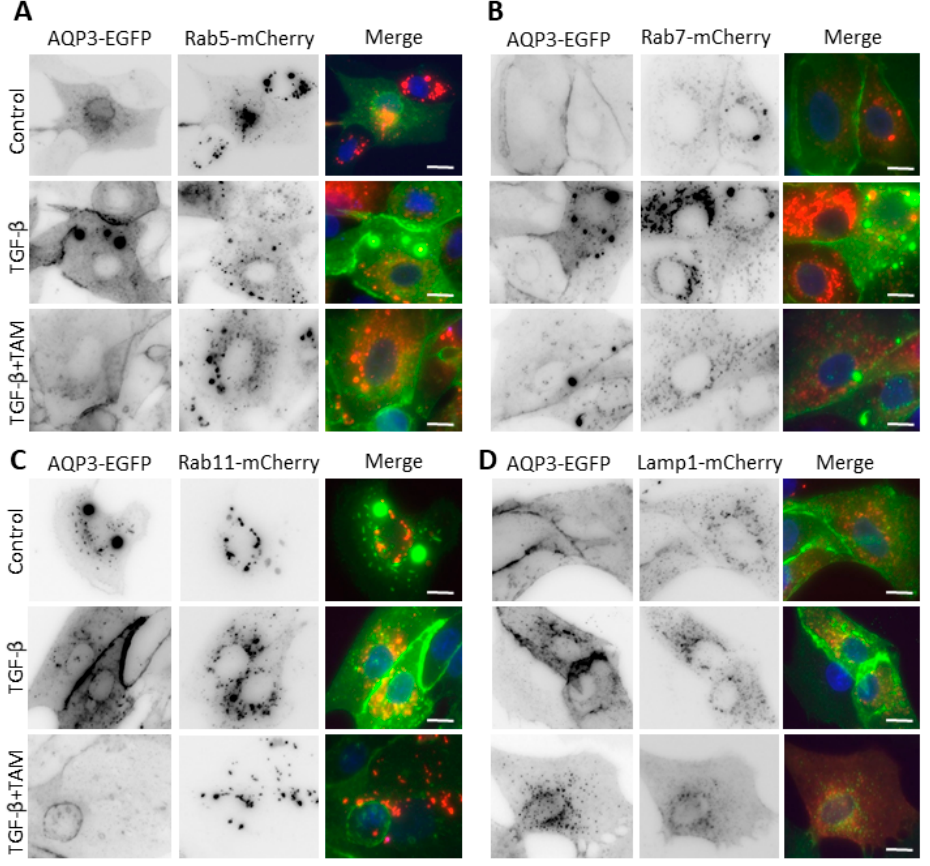
Figure 5. The localization of AQP3-EGFP and Rab5-mCherry, Rab7-mCherry, Rab11-mCherry, and Lamp1-mCherry in MDCK cells treated with TGF- β and TGF- β +TAM. Representative fluorescence images of AQP3-EGFP-MDCK cells transiently transfected with plasmids encoding Rab5-mCherry ( A ), Rab7-mCherry ( B ), Rab11-mCherry ( C ), and Lamp1-mCherry ( D ) exposed to TGF- β for 48 h and TGF- β +TAM after 48 h (24 h co-treatment). Forty-eight hours post transfection, cells were fixed and stained with Hoechst (blue, nuclei). Data are representative pictures from 3 different experiments. Scale bar 15 µm.